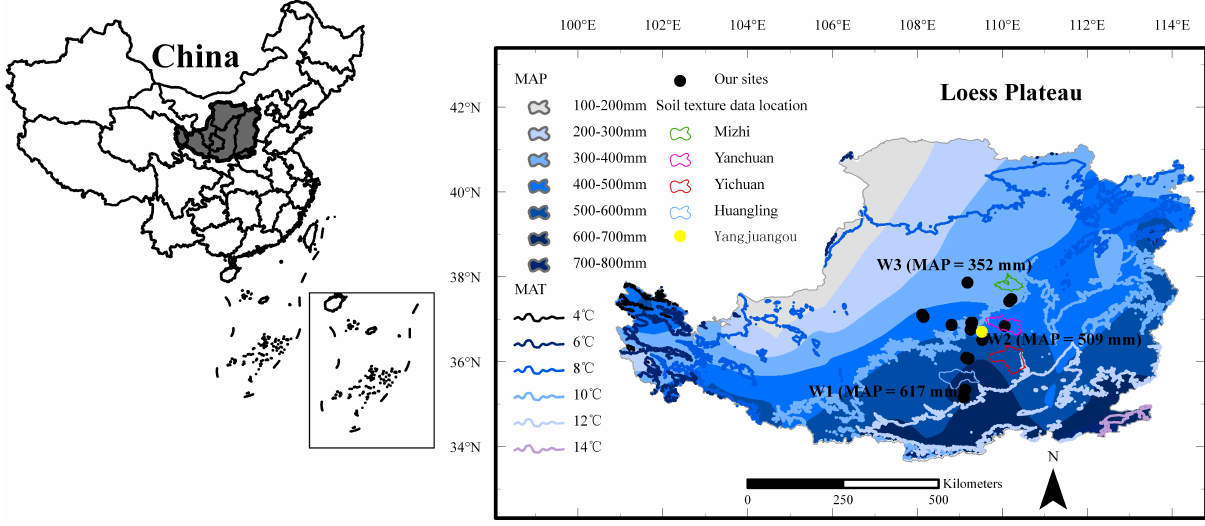
Fig. 1. Map of the study area on the Loess Plateau in central China and the distributions of the mean annual temperature (MAT) and mean annual precipitation (MAP). A total of 30 sites were selected. Sites W1, W2 and W3 are three watersheds located in the northern, middle and southern parts of the study area,